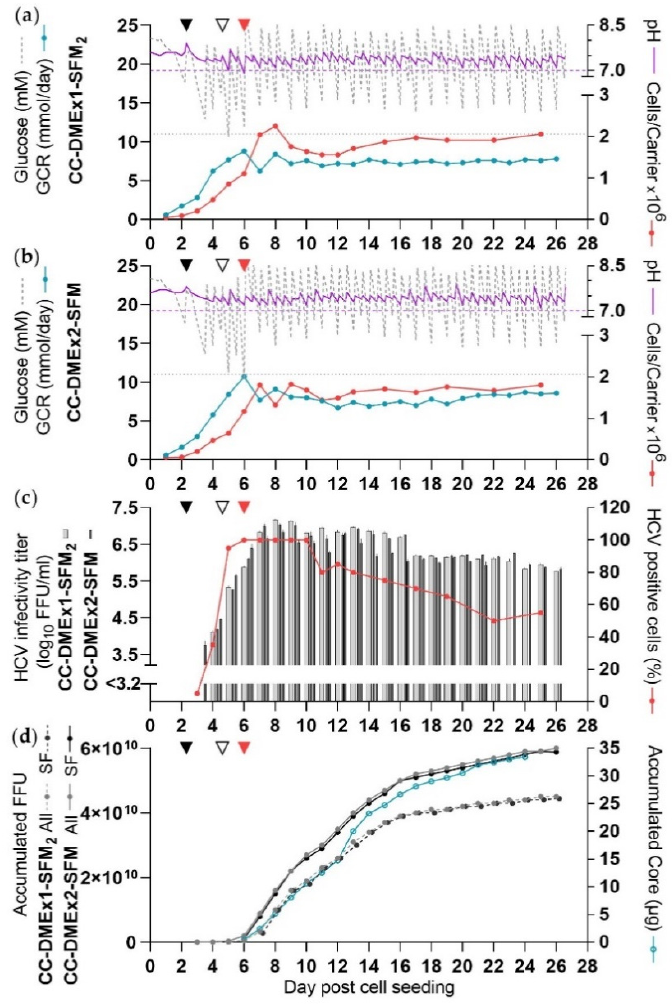
Figure 5. SF HCV production in the CelCradle™ with two DME (CC-DMEx1-SFM ₂ and CC-DMEx2- SFM). Two replicate CelCradle™ cultures were seeded with 2 × 10 5 cells/carrier and infected as described for Figure 1 at 2 dpcs (black arrow). Purple dashed line: pH 7, grey dotted line: 11 mM glucose. At 3 dpcs medium was exchanged in the evening and from 4 dpcs medium was exchanged every morning in both cultures. Different DME frequencies, ( a ) CC-DMEx1-SFM ₂ , morning versus ( b ) CC-DMEx2-SFM, morning and evening, were initiated at 4 dpcs. Glucose and/or NaHCO 3 solution was added and glucose and pH were measured as described in Figure 1. Carriers were sampled for cell count every day until 13 dpcs and then less frequently. From 6 dpcs (morning) both cultures were maintained in SFM (red arrow). ( a , b ) Glucose concentration, pH, GCR, cells/carrier. ( c ) HCV infectivity titers and percentage HCV NS5A positive cells; the curve represents both cultures as identical values were recorded throughout the experiment. ( d ) Accumulated FFU calculated according to harvest volumes of 450 mL. Accumulated amounts of HCV Core protein from CC- DMEx2-SFM SF harvests until 24